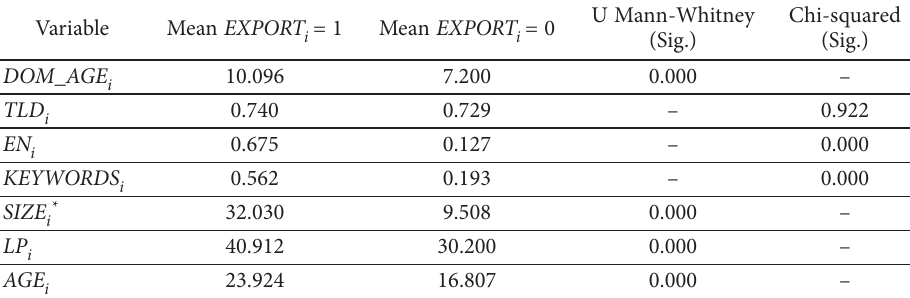
Table 3. Results of the comparison made between exporters and non